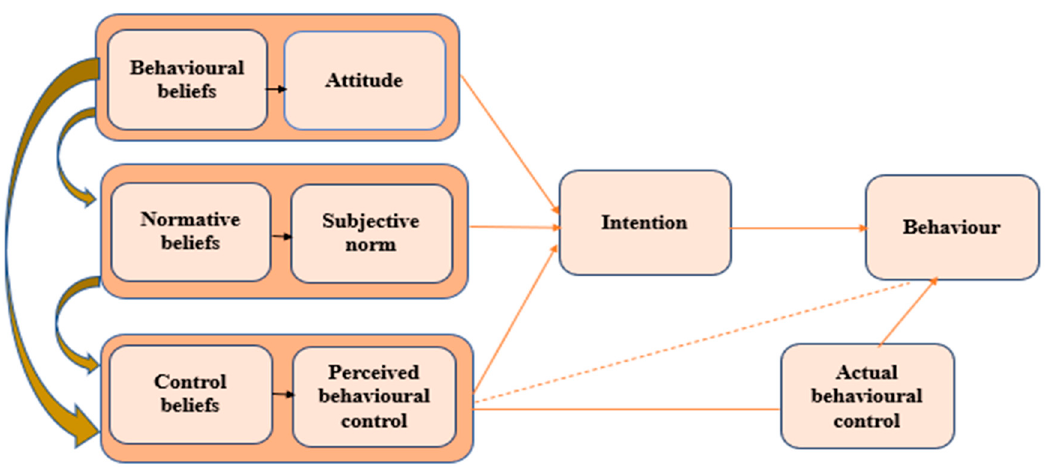
Figure 2. Theory of Planned behaviour (TPB).